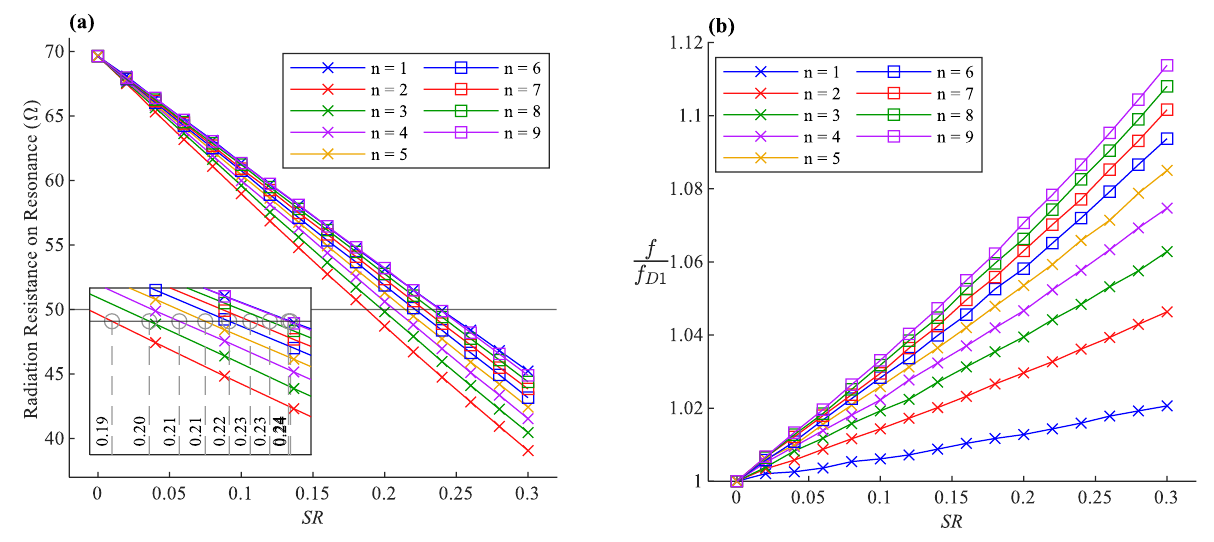
Figure 3. ( a ) Radiation Resistance of the antenna on resonance frequency. Inset: zoomed-in detail of the crossing around the 50 Ω line. ( b ) The resonance frequency of the antenna normalized to the resonance frequency of the straight half-wave dipole ( 𝑓 𝐷1 ).